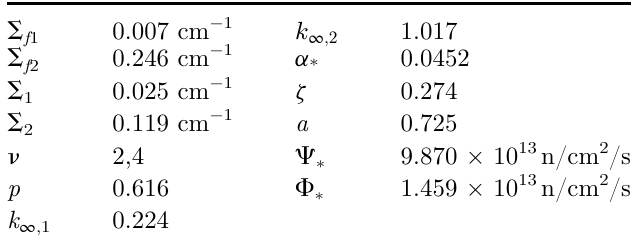
Table 2. Typical numerical data for our 2-group model.